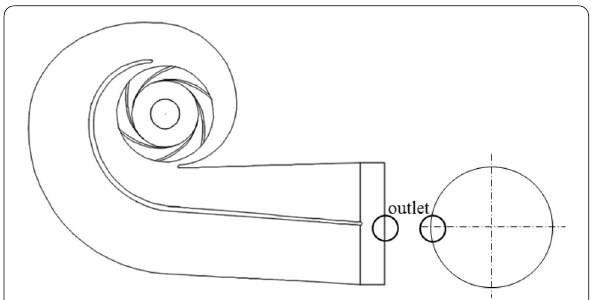
Figure 15 Location of vibration monitoring point